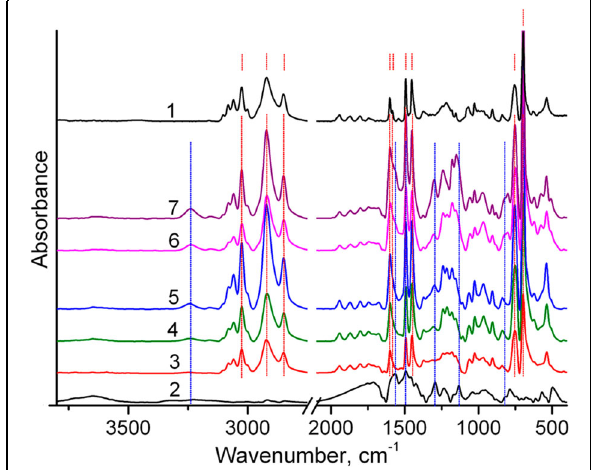
Fig. 2 FTIR spectra of PS (1), PANI (2), and PS/PANI-LSA composites: NC3 (3), NC3 (4), NC3.5 (5), NC11 (6), NC15 (7). Main characteristic peaks of PS and PANI-LSA are marked with dashed red and blue lines , respectively. All marks correspond to the frequencies discussed in the